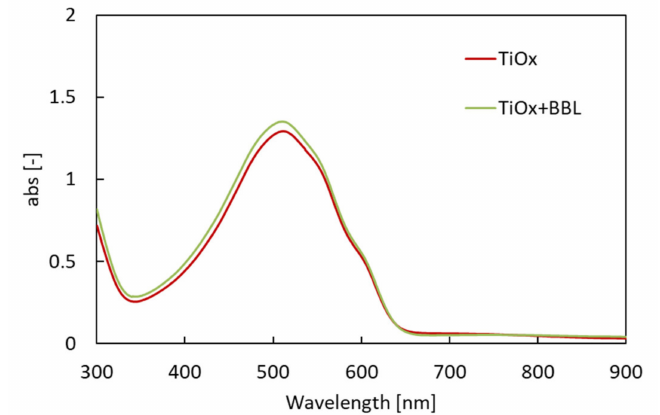
Figure 4. UV–Vis/near-IR spectrum for photoactive layers.